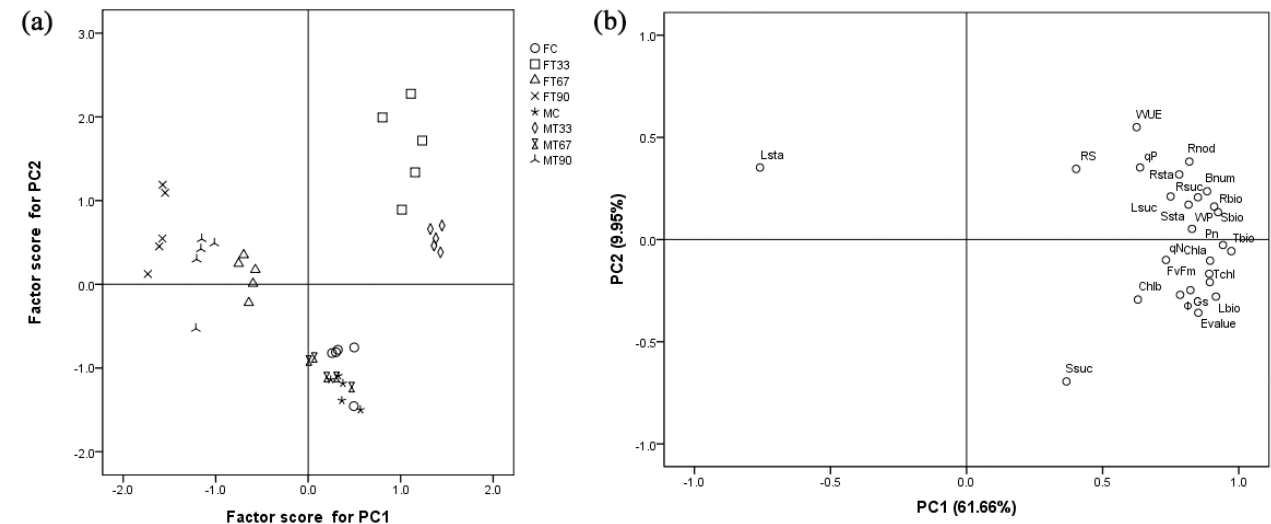
Figure 6. Results of the principal component analysis (PCA) showing ( a ) distributions of females and males of H. rhamnoides under different sand burial treatments ( b ) correlations of factor load- ings for all ecophysiological parameters in the interactive treatments of sex and sand burial. The variable acronyms are as follow: P n , light photosynthetic rate; E, transpiration rate, G s , stomatal conductance; F v /F m , dark-adapted quantum yield of PSII; Φ , effective quantum yield of PSII; qN, non-photochemical quenching coefficient; qP, photochemical quenching coefficient; Lsta, leaf starch content; Ssta, stem starch content, Rsta, root starch content; Lsuc, leaf sucrose content; Ssuc, stem sucrose content; Rsuc, root sucrose content; Chl a , Chl b and Tchl, content of chlorophyll a+b and total chlorophyll content, respectively; Lbio, leaf biomass; Sbio, stem biomass; Rbio, root biomass; RS, root-to-shoot ratio; WP, water